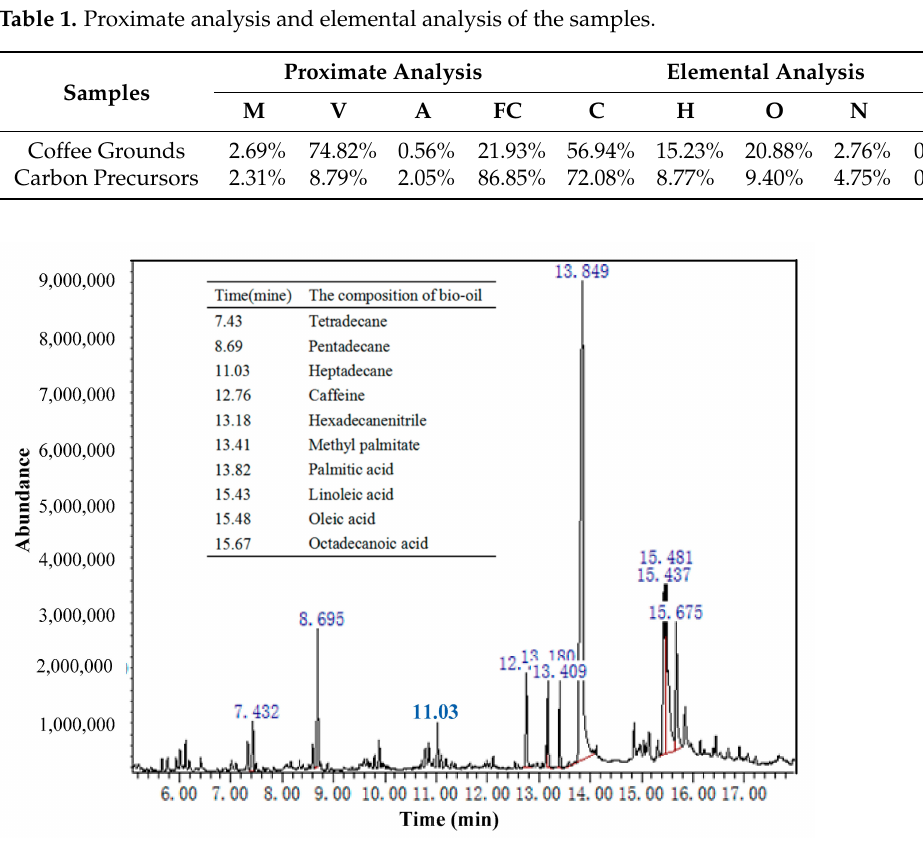
Figure 4. GC/MS chromatograms of